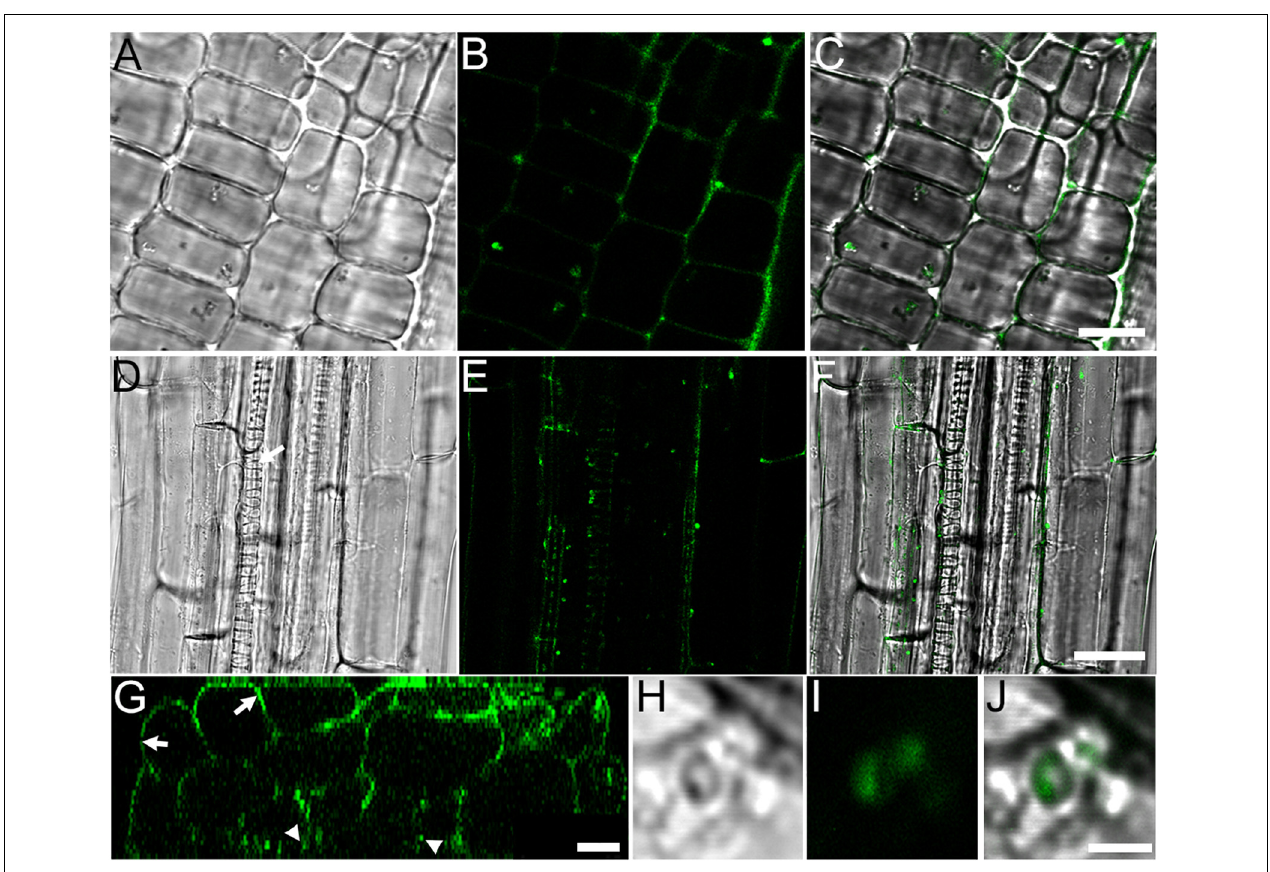
FIGURE 1 | RF67 bacteria colonizes A. thaliana roots in 10-days old seedlings. (A–C) Localization of bacterial in the apoplast of epidermis cells in root apical meristem. Scale bar is 10 µ m. (D–F) Localization of bacteria in the apoplast of root differentiation zone. Scale bar is 25 µ m. Arrow denotes protoxylem vessel. (G) Z-section taken through the stack shown in (D–F) . Arrows denote root surface and arrowheads point bacterial cells in the apoplast two to three cell layers below the root surface. Scale bar is 10 µ m. (H–J) Image of GFP-tagged bacteria in root apoplast. Scale bar is 2 µ m. (A,D,H) Differential interference contrast (DIC) images; (B,E,G,I) GFP fluorescence images; (C,F,J) merge of DIC and fluorescence